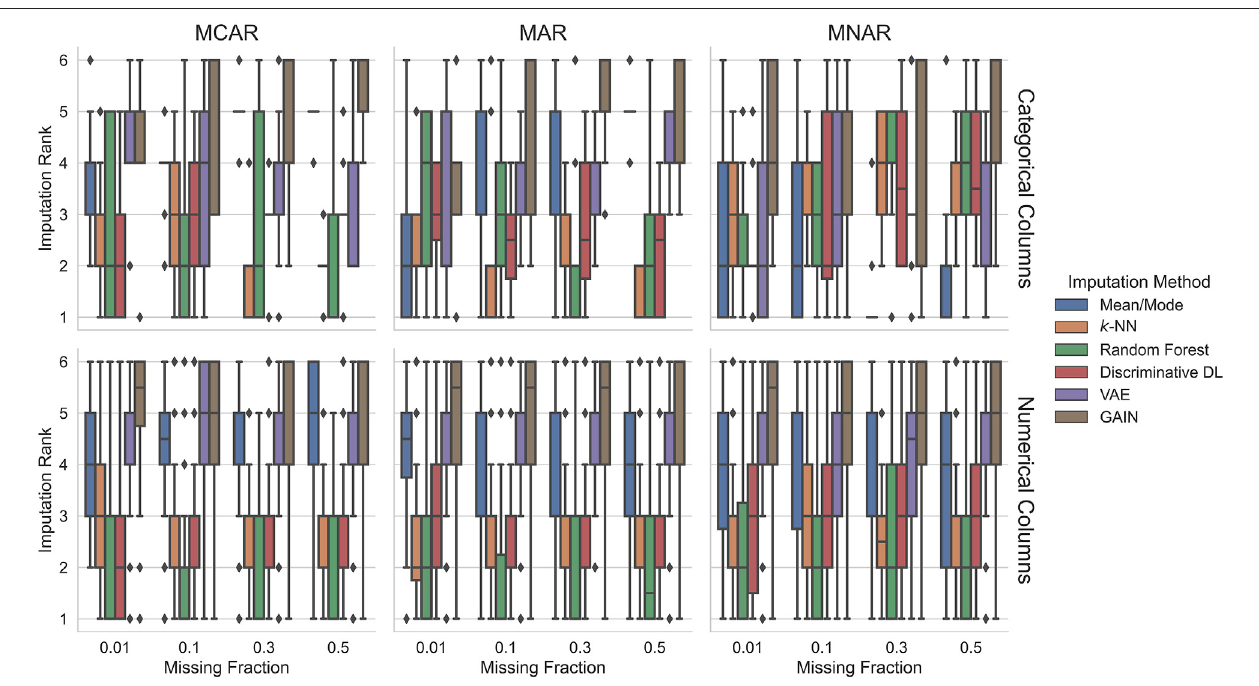
FIGURE 2 | Imputation ranks of the imputation methods trained on incomplete data. Ranks are computed for each experimental condition characterized by the dataset, missingness pattern, and missingness ratio. Since we compare six imputation methods, the possible imputation ranks range between 1 and 6. Similar to the training on fully observed data random forest, k -NN and discriminative DL perform better than generative deep learning methods in most settings. In the MNAR conditions, the imputation quality of all the imputation approaches degrades in favor of mean/mode that outperforms the other for 30% and 50% missingness.